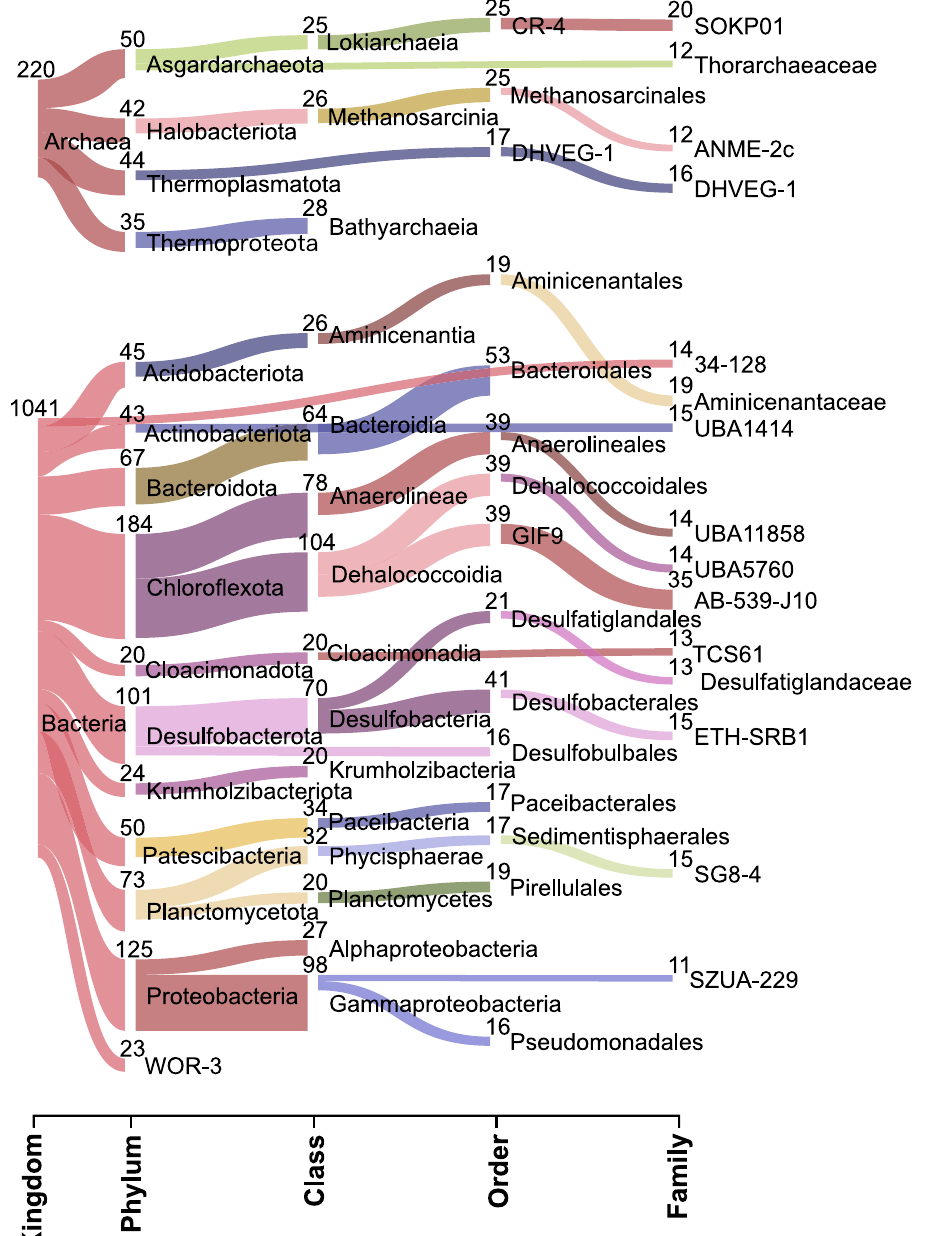
indicating the number of MAGs recovered for a given lineage. The diagram shows thetop25taxawiththelargestnumberofMAGsateachlevel.Detailedstatisticsfor 1261 MAGs are provided in Supplementary Data